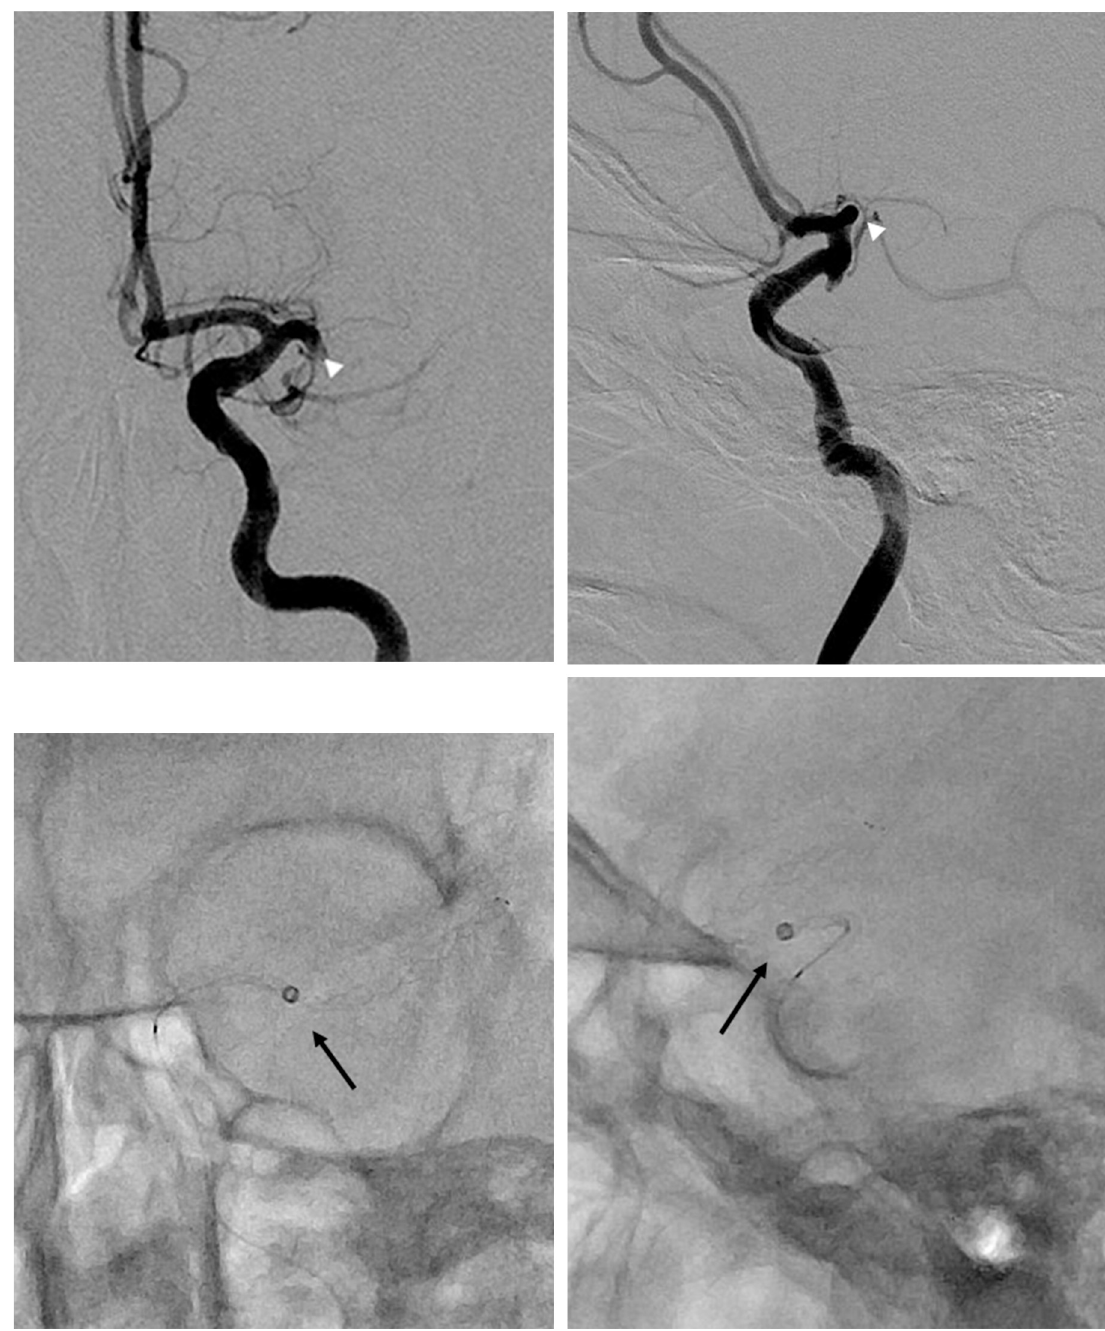
Fig 1. Distal access catheter (DAC) tip position during combined stent-retriever and aspiration technique in the distal DAC group. (A, B) Left anteroposterior (A) and lateral (B) internal carotid artery angiogram images show occlusion of the left middle cerebral artery (arrowheads). (C, D) The DAC was advanced as close to the proximal end of the thrombus as possible in the middle cerebral artery